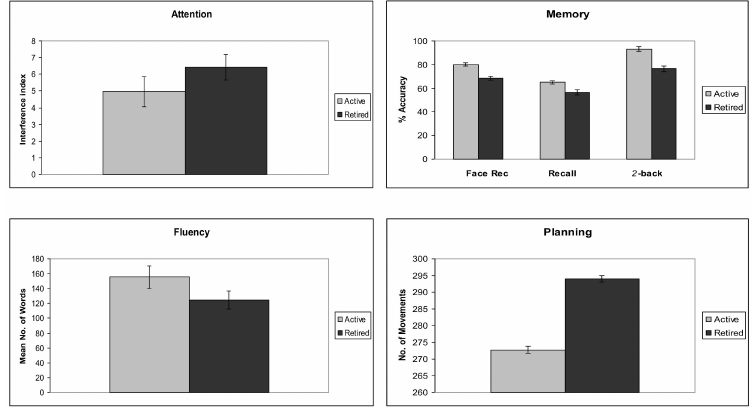
Figure 1. Results of active and retired participants in the di ff erent cognitive